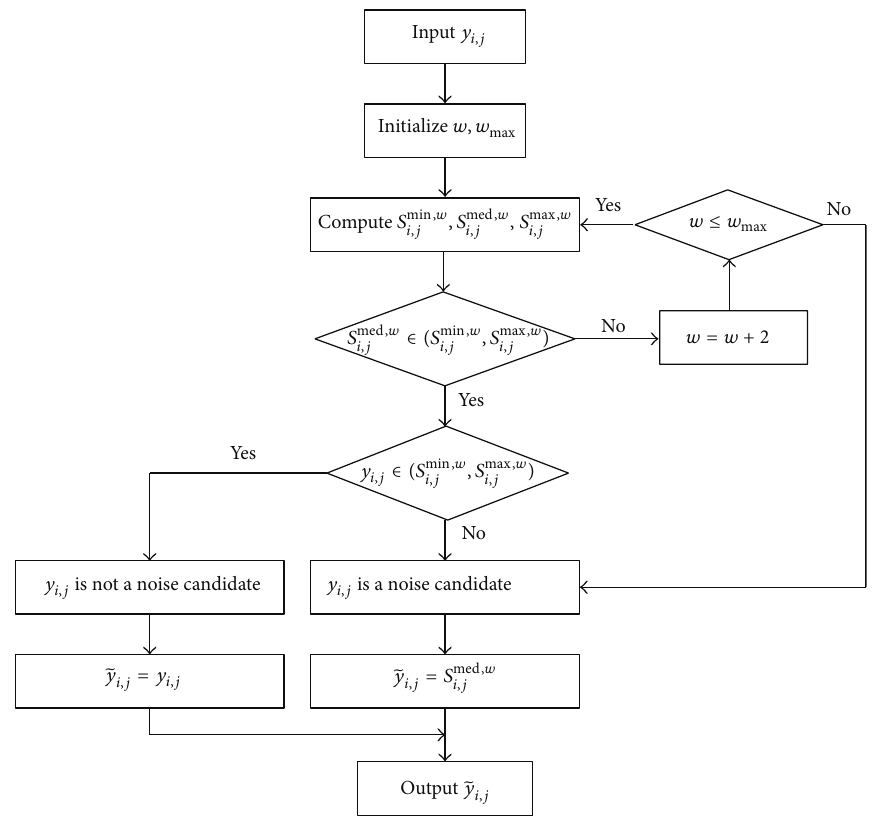
Figure 3: Flowchart of adaptive median